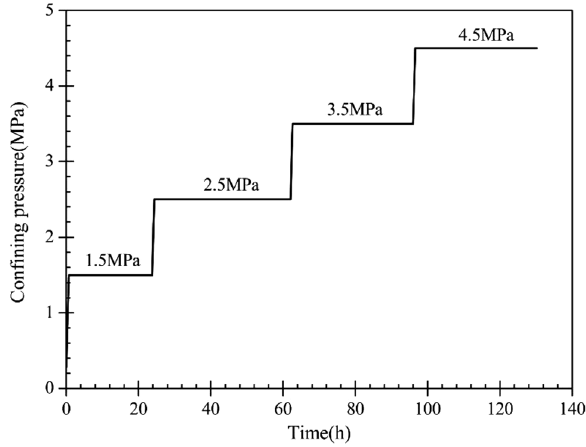
Fig. 7 Loading time history curve of soil